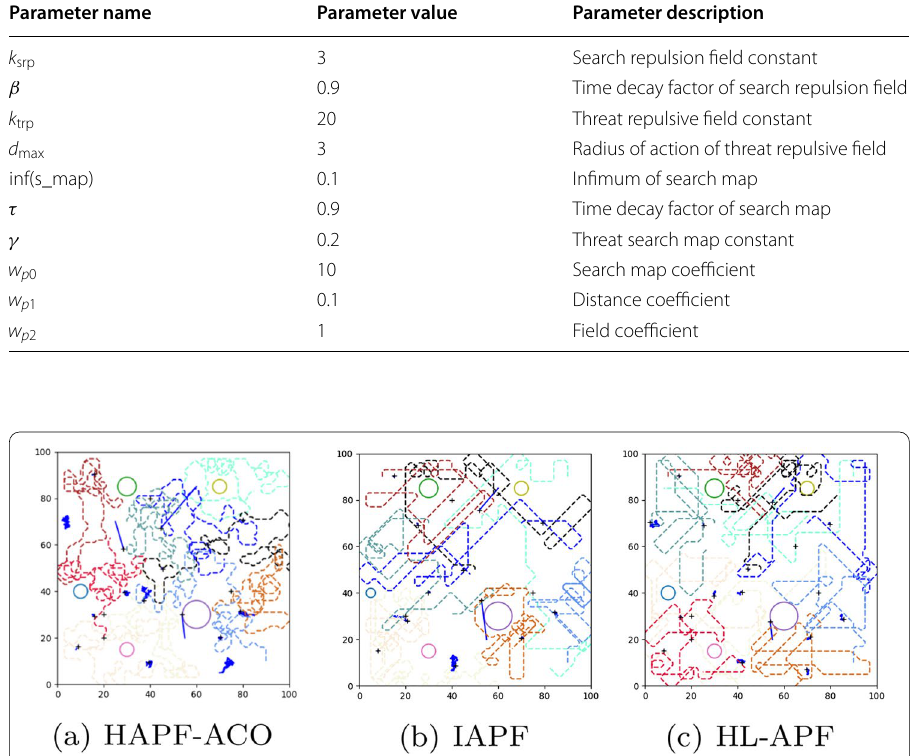
Fig. 4 Ten UAVs’ paths generated after 250 iterations for the